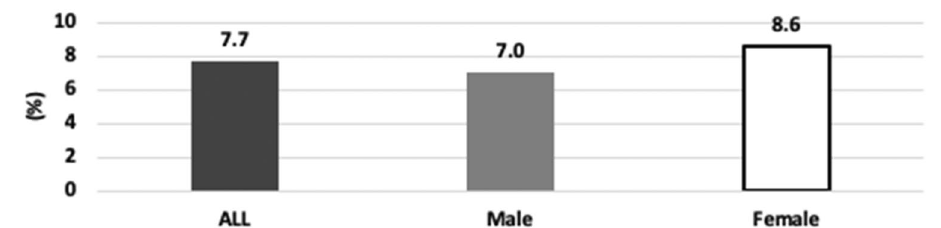
Figure 1. Prevalence of thoracic diffuse idiopathic skeletal hyperostosis.